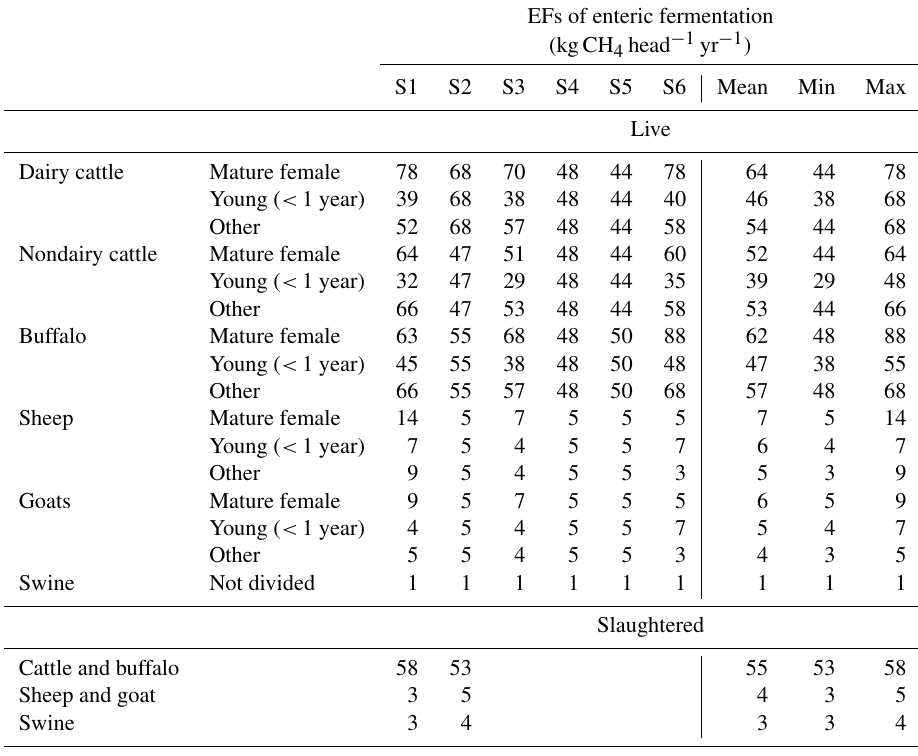
Table 1. Emission factors (EFs) of enteric fermentation collected from literature and summarized mean, minimum and maximum of EFs used in this study. The S1–S6 indicate values collected from references list in the